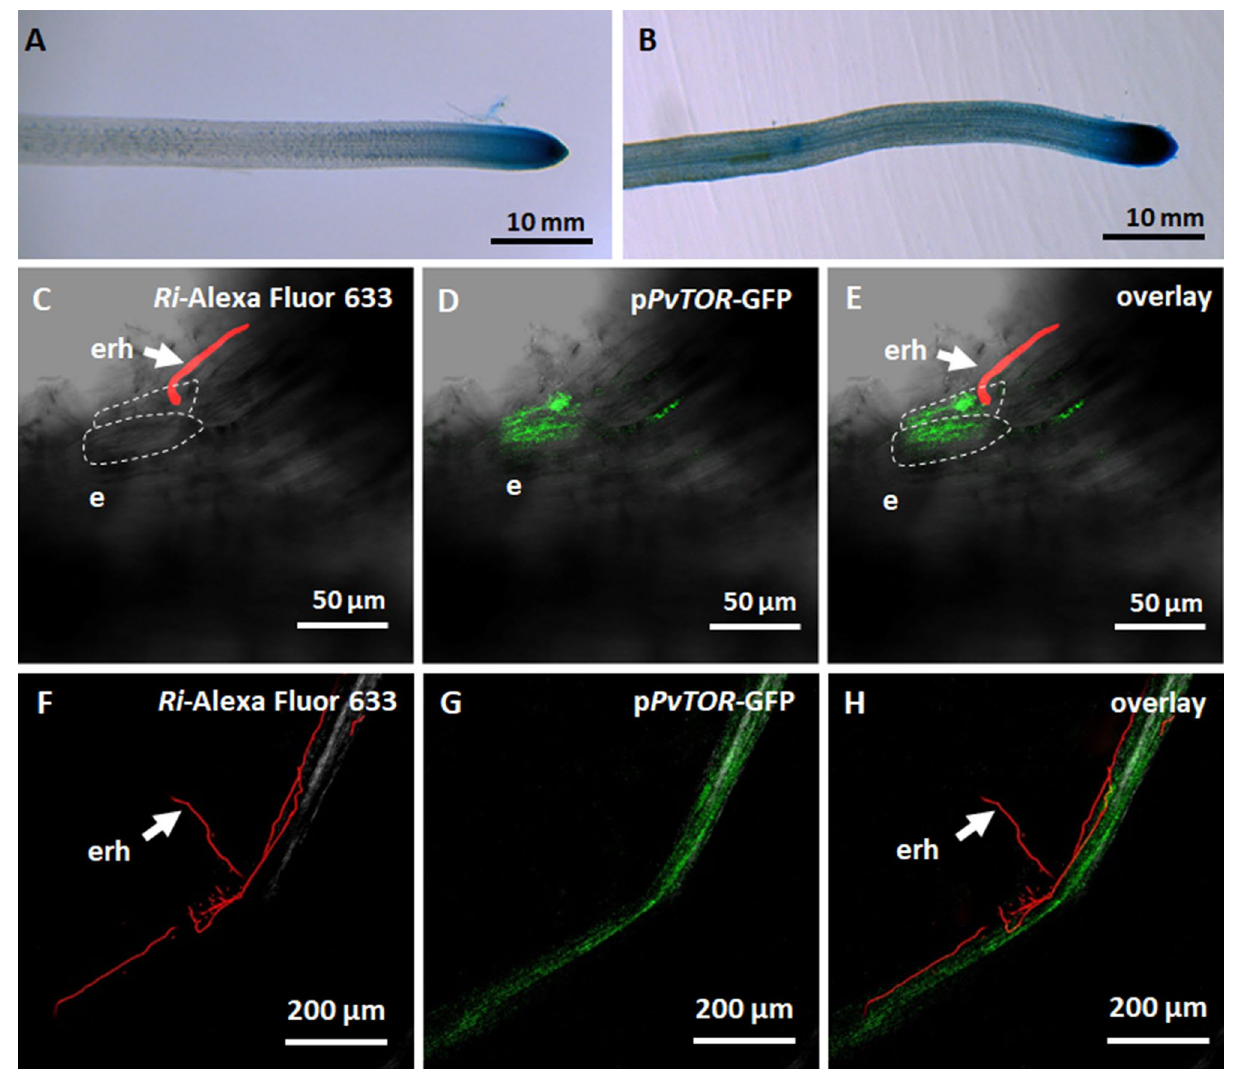
Figure 2. Spatial expression of the PvTOR promoter in R. irregularis -inoculated transgenic P. vulgaris roots. ( A–B ) Histochemical GUS staining of ( A ) uninoculated and ( B ) R. irregularis- inoculated PvTOR pro :: GUS - GFP transgenic roots at 2 wpi. ( C–E ) Transmitted light and confocal images of PvTOR pro :: GUS - GFP transgenic roots at 2 dpi with R. irregularis showing ( C ) extraradical hyphae in contact with root epidermis, ( D ) induction of PvTOR pro :: GUS - GFP expression in the epidermal cells at the site of extraradical hyphal contact and ( E ) overlay image. ( F–H ) PvTOR pro :: GUS - GFP transgenic roots at 2 wpi with R. irregularis showing ( F ) extraradical hyphae on the root epidermis surface, ( G ) induction of PvTOR pro :: GUS - GFP expression in the root colonized by R. irregularis , and ( H ) overlay image. WGA Alexa Fluor 633 was used to stain (red) fungal cell walls. dpi, days post inoculation; wpi, week(s) post inoculation; e, epidermis; erh, extraradical